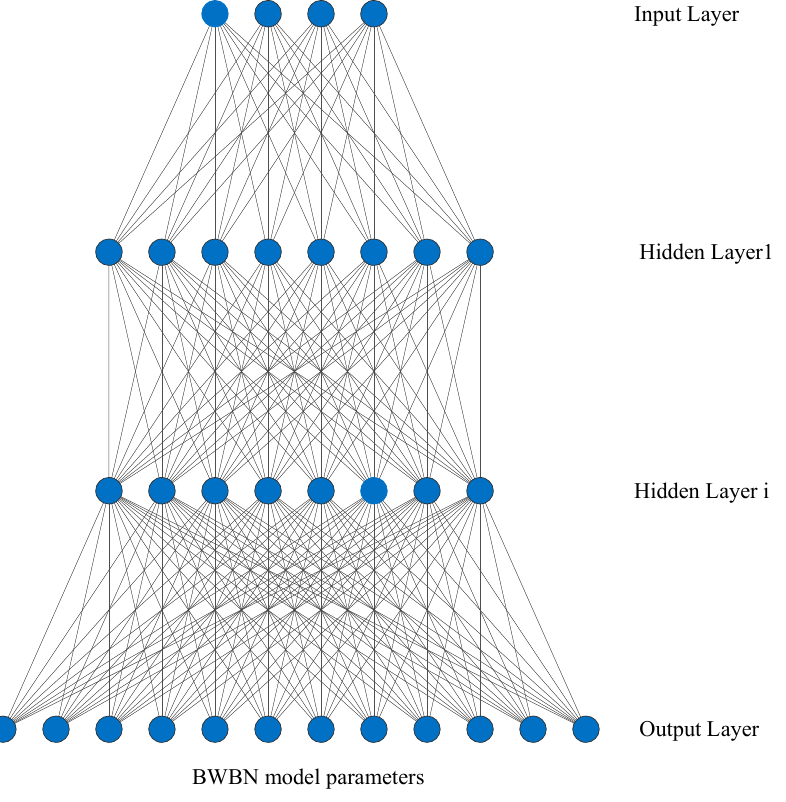
Figure 4. A schematic neural network model for BWBN parameter identification.